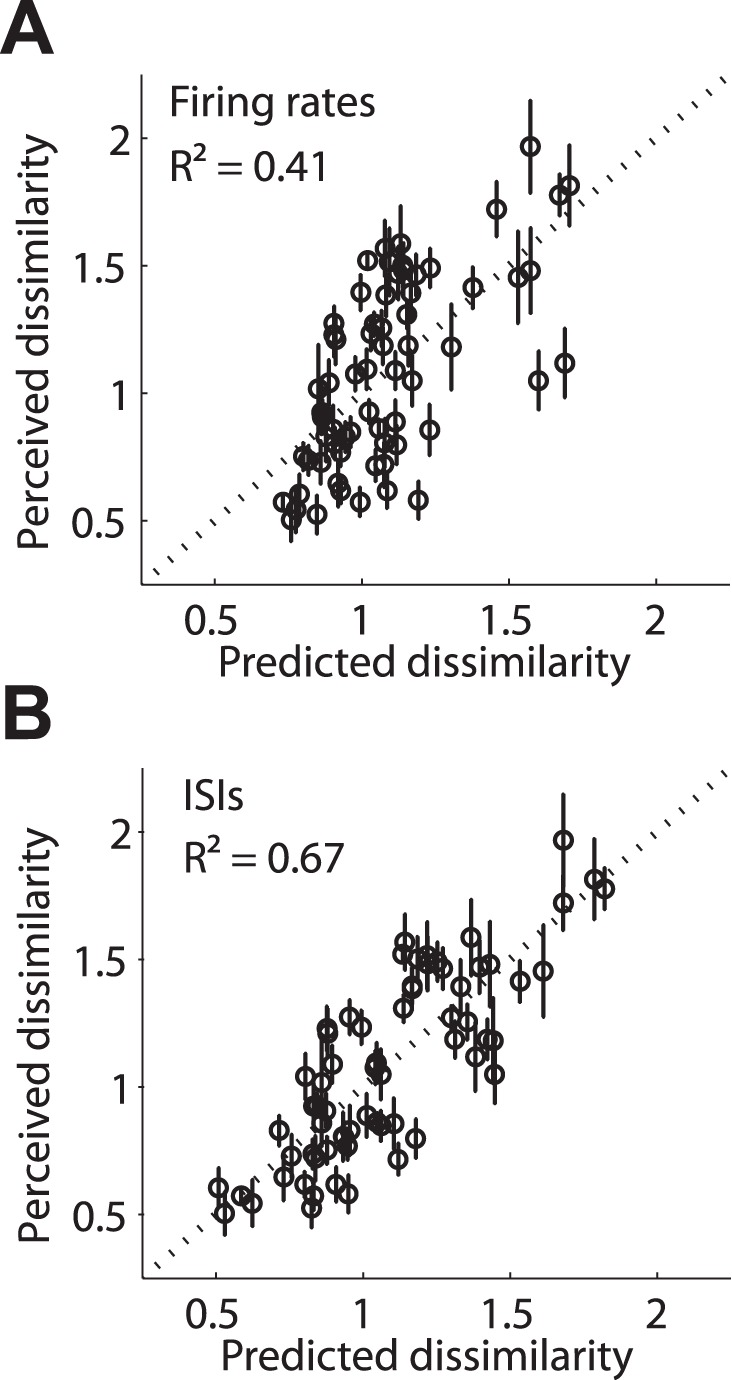
Predicting psychophysical responses to noise stimuli.Predicted versus perceived dissimilarity as calculated from (A) firing rates, and (B) ISIs. Each dot represents the mean perceived dissimilarity of one pair of stimuli. Predictions based on ISI distributions are significantly better than those based on firing rates alone, suggesting that spike timing contributes to perception. Error bars denote standard error of the mean.